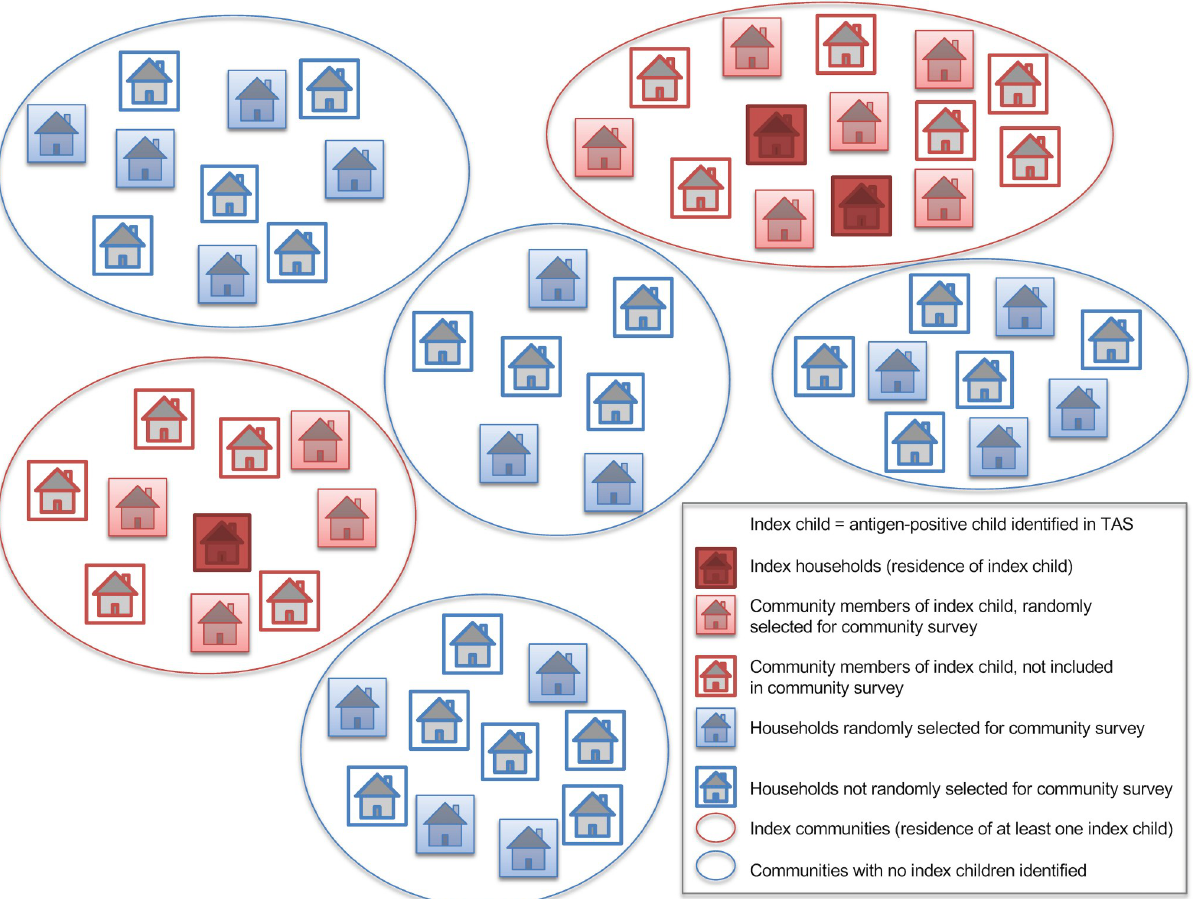
Fig 3. Definitions of subgroups used for analyses. An index child was defined as an antigen-positive child identified in TAS. Index households and communities were defined as those where an index child lived. These groups were compared with households and communities without an index